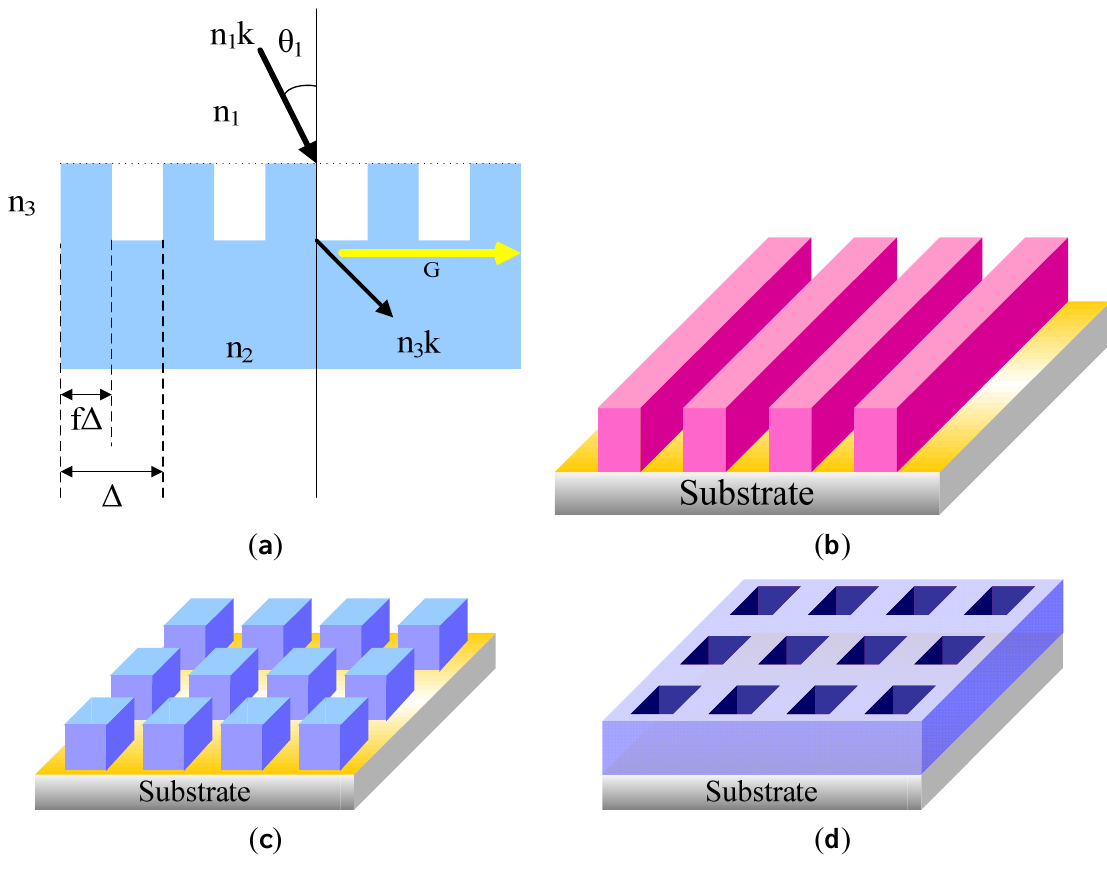
Figure 19. ( a ) Cross section profile of a one-dimensional periodic subwavelength grating; ( b ) One-dimensional periodic subwavelength gratings; ( c ) Symmetric two-dimensional subwavelength relief gratings; symmetric two-dimensional subwavelength concave gratings. Reprinted from Reference [232] with